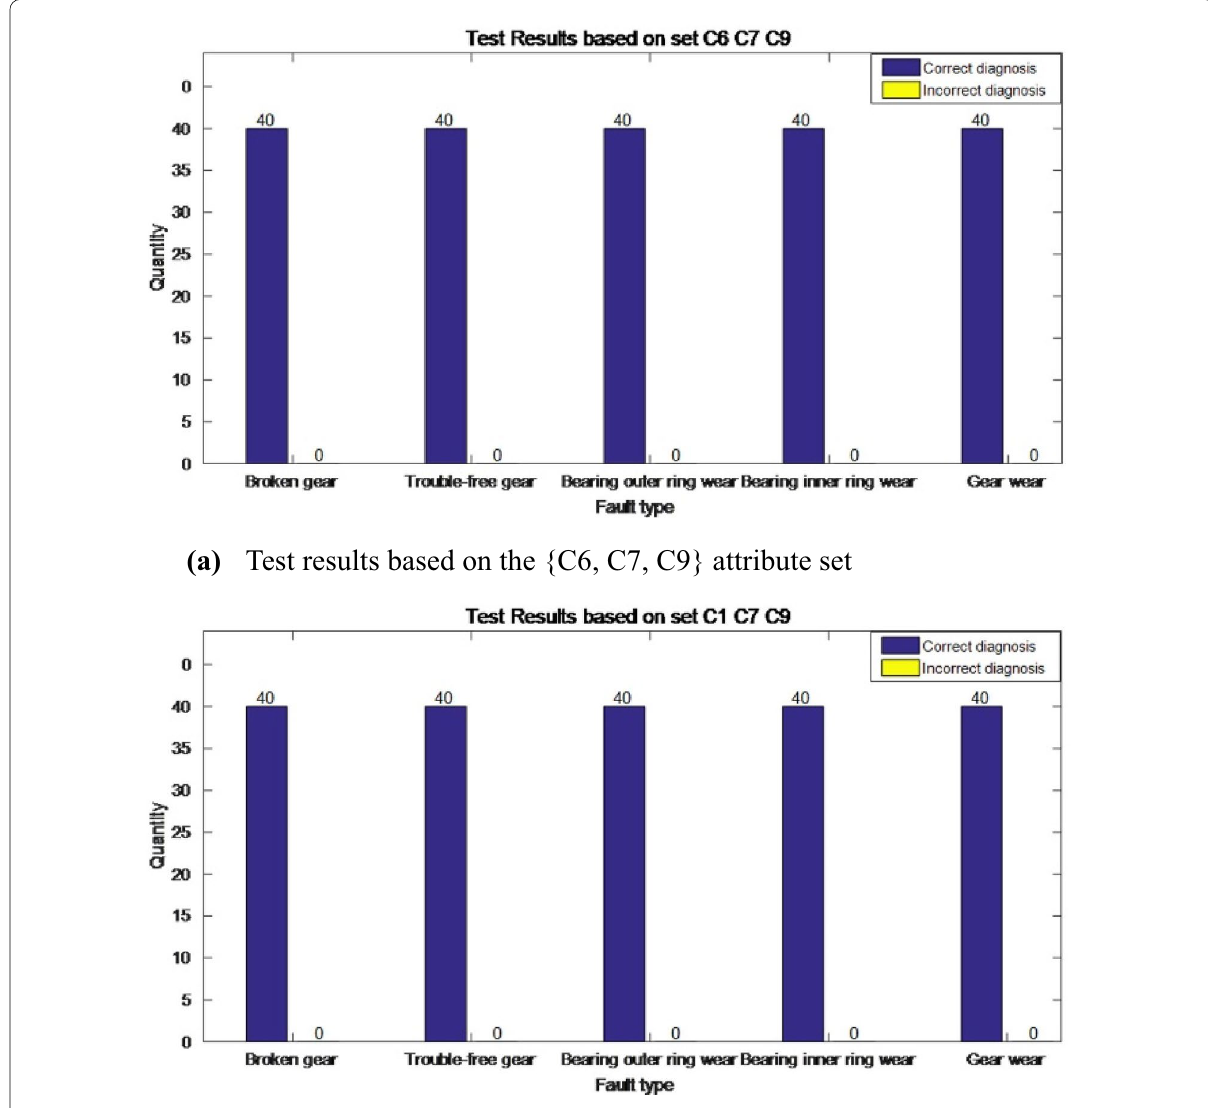
Figure 9 Results based on six sets of testing